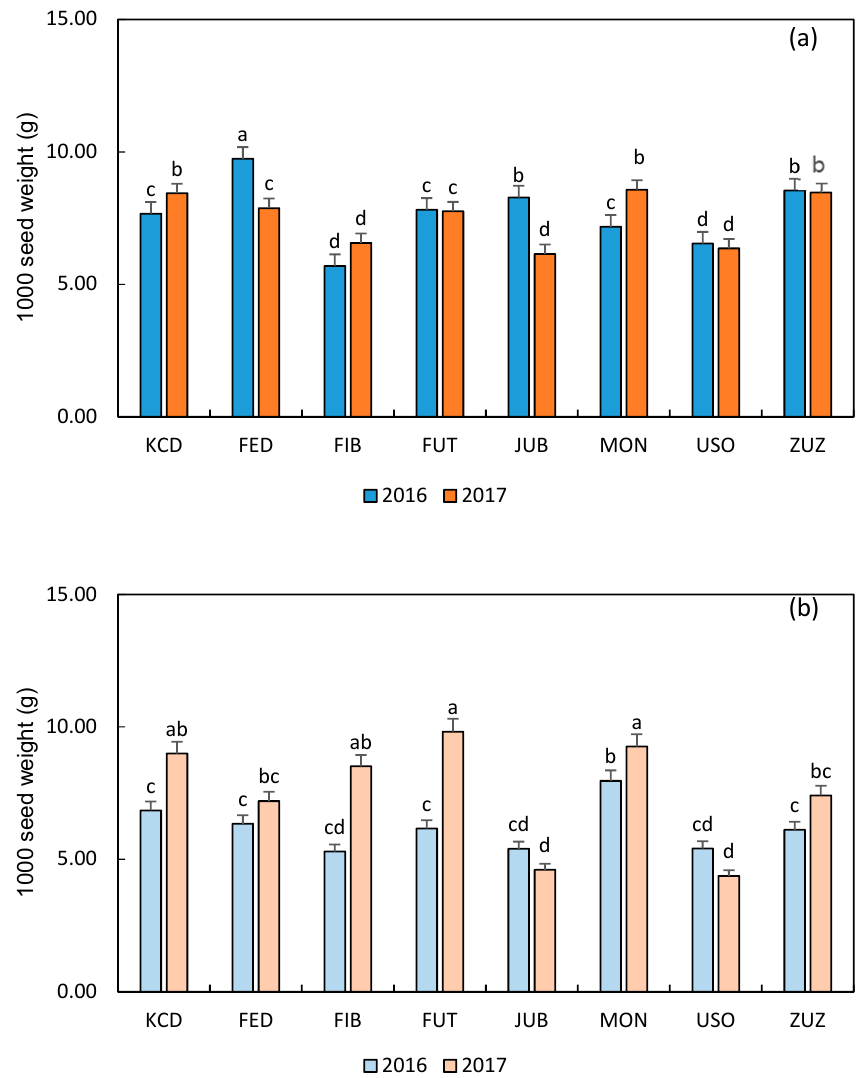
Figure 4. One thousand seed weight in control plants ( a ) and in plants with inflorescence harvested at flowering ( b ) (KCD = KC Dora; FED = Fedora 17; FIB = Fibrol; FUT = Futura 75; JUB = Jubileu; MON = Monoica; USO = Uso-31; ZUZ = Zuzana). Means followed by the same letter are not significantly different (SNK at the 5% level). Error bars are standard deviations.